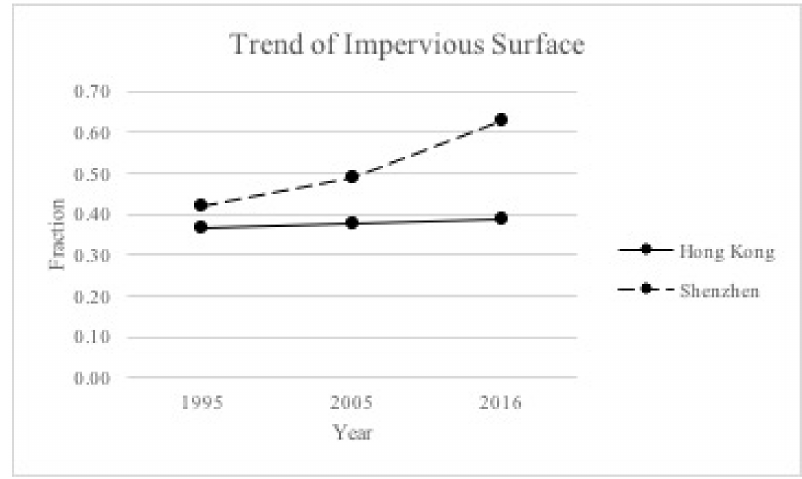
Figure 14. Trend of impervious surface for Hong Kong and